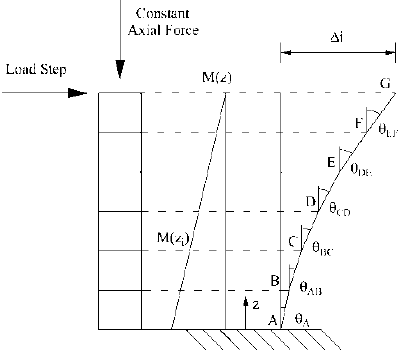
Figure 9. Evaluation of the relative displacement between two sections of an element in bending.